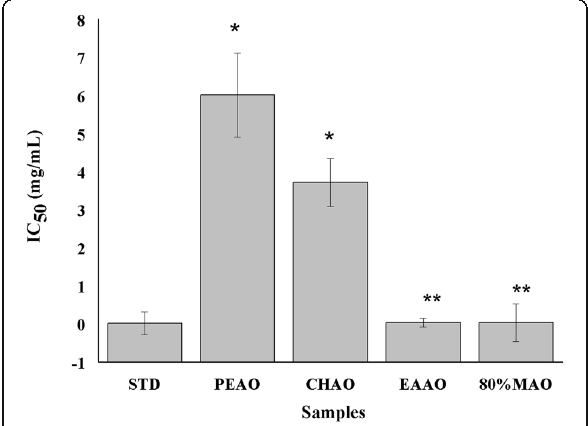
Fig. 1 DPPH scavenging activity of Petroleum ether, Chloroform, Ethyl acetate, and 80 % Methanol Extracts of A. occidentale. * PEAO: Petroleum ether extract of A. occidentale, CHAO: Chloroform extract of A. occidentale, EAAO: Ethyl acetate extract of A. occidentale, 80% MAO: 80% Methanol extract of A. occidentale. * Results are expressed as mean ± SD ( n =3). ‘ * ’ indicates values significantly differ from the standard at P ˂ 0.001. ‘ ** ’ indicates values significantly differ from the standard at P ˂ 0.05.